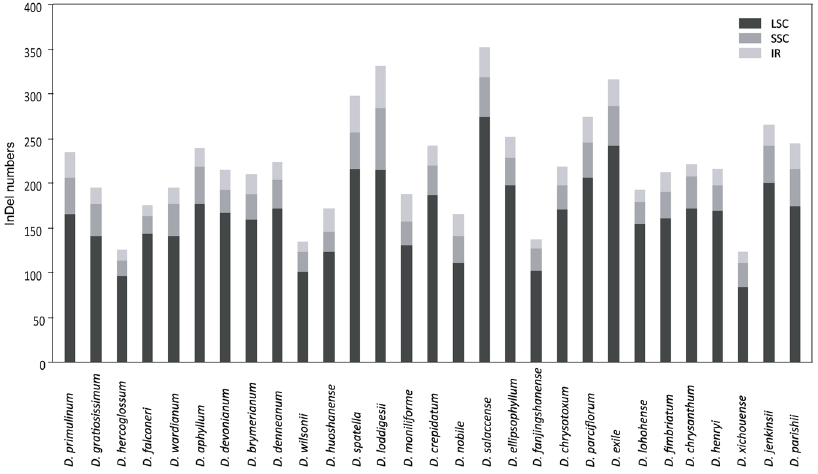
Figure 1. InDel distribution among different Dendrobium plastomes. The InDel mutations were determined based on the comparison between plastoms of each tested Dendrobium species and D . officinale . Histograms with different colors indicate the numbers of InDels in LSC, SSC, and IR